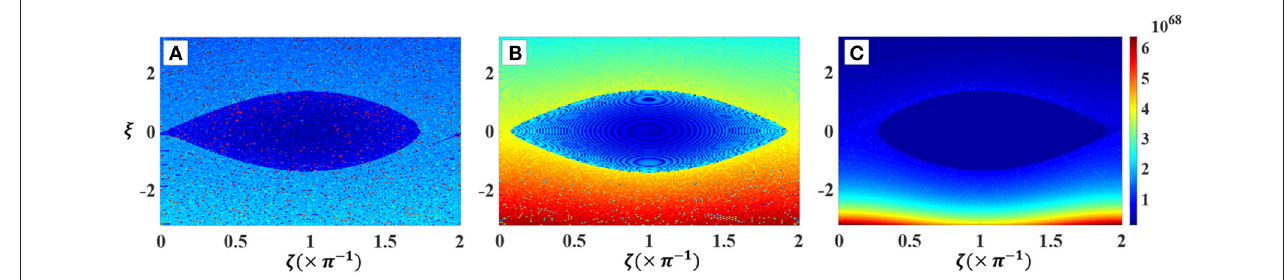
FIGURE 9 | Formation of phase-space electron hole from test particle trajectories. (A) upstream location, (B) equator, and (C) downstream location relative to the wave propagation